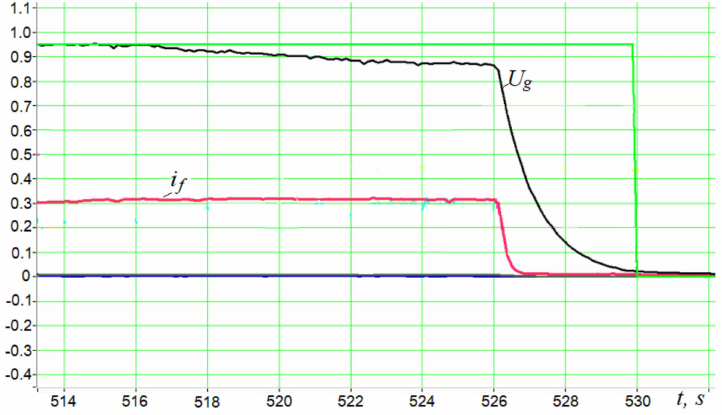
Figure 10. The results of protection system operation during a frequency decrease in a no-loaded generator: U g is the RMS value of the generator voltage, i f is the field current. A feature of the proposed approach is that testing the excitation system in case of thyristor fault is possible. A thyristor fault (i.e., when the thyristor does not turn on) can be physically realized by disconnecting the gate impulse from the digital model. Such retained its efficiency and restored the required value of the excitation current for 1.5 s. The field current exhibited pulsation in this case, but it did not influence the terminal voltage of the generator.